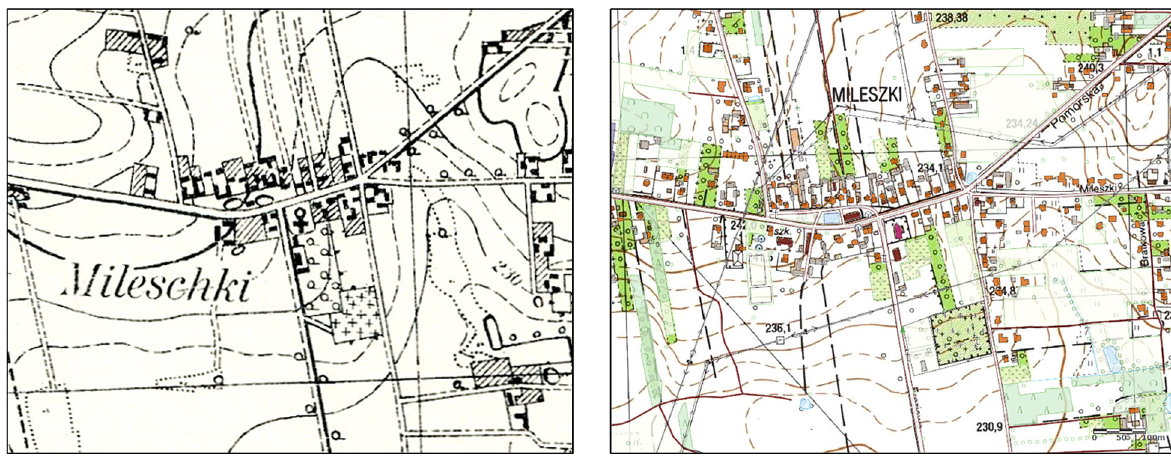
Fig. 2. Morphological changes in the former village of